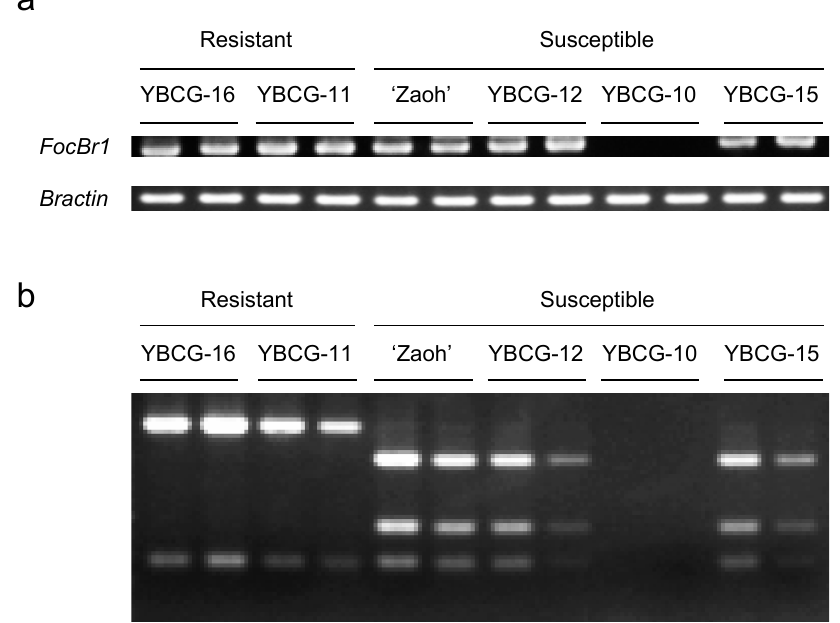
Figure 2. Expression and genotype of FocBr1 in For resistant and susceptible lines. ( a ) Expression of FocBr1 and Bractin (control) was confirmed by RT-PCR. ( b ) DNA fragments of RT-PCR products digested by Hin d III. YBCG-16 and YBCG-11 have FocBr1 / FocBr1 homozygous or FocBr1 / focbr1-1 heterozygous alleles. “Zaoh”, YBCG-12 and YBCG-15 have focbr1-2 / focbr1-2 homozygous or focbr1-